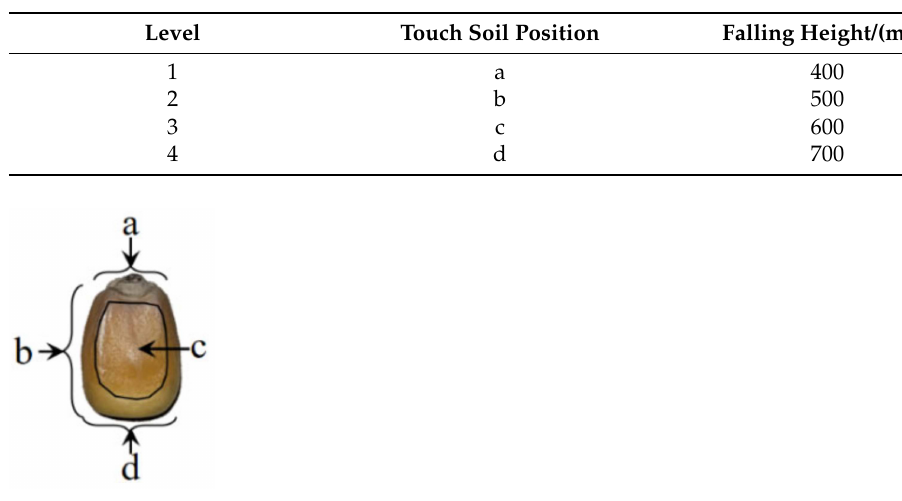
Table 4. Experiment factor level.